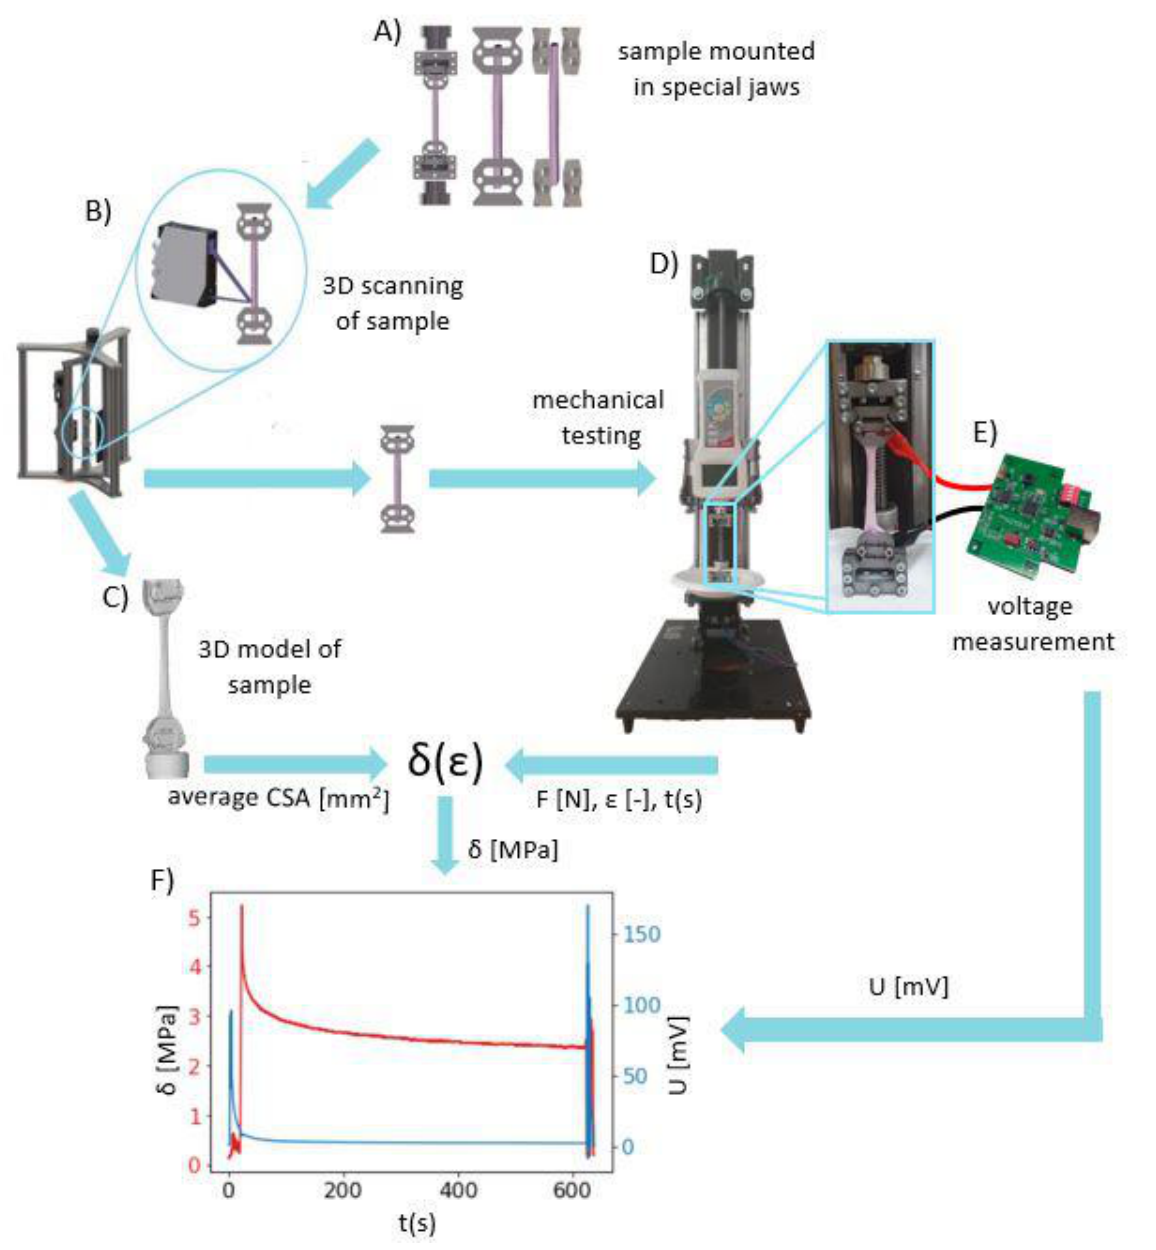
Figure 5. The workflow diagram of validation of our developed system for the precise measurement of electrical potentials and mechanical properties of soft tissues: ( A ) Mounting of the tendon sample in jaws that were produced in-house, ( B ) scanning the sample using the 3D Scanner system [14], ( C ) obtaining the STL 3D model of sample geometry for calculating the average cross-sectional area, ( D ) mechanical testing on the SMT using the protocol presented in Figure 4 to collect time-dependent force F and strain (cid:101) , ( E ) collecting potential difference by the use of the DPMPD connected to the sample holders during mechanical testing, ( F ) superimposed curves of stress in time (obtained from mechanical testing) with time-dependent potential differences (obtained using the